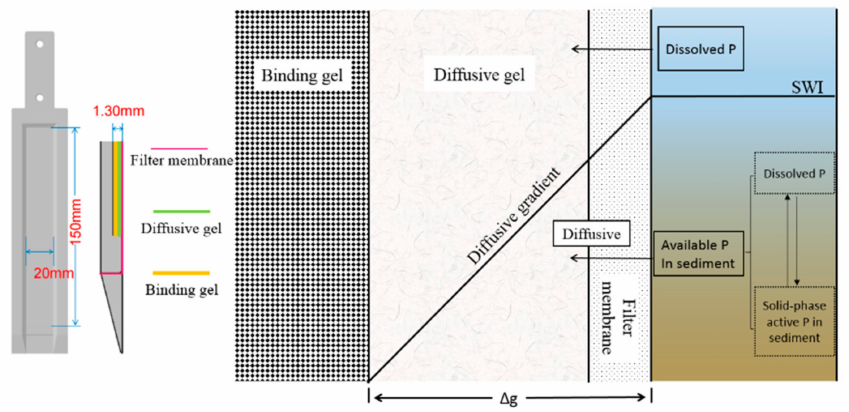
Figure 2. Layout of the DGT device.